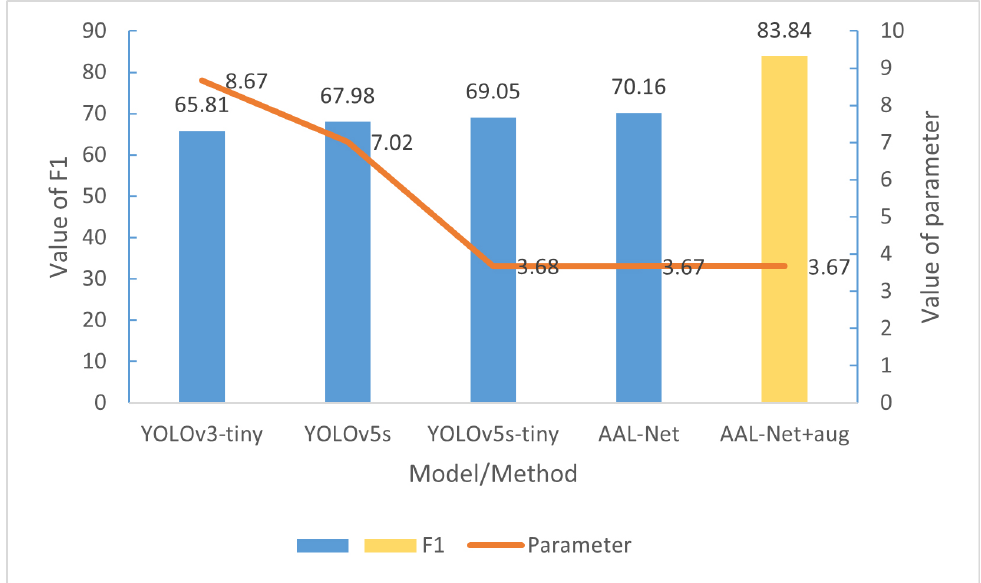
Figure 10. In the self-made dataset, the comparison between F1 values and parameter values of different methods, the horizontal axis represents different methods, the left half of the vertical axis represents F1 values, and the right half of the vertical axis represents parameter values.